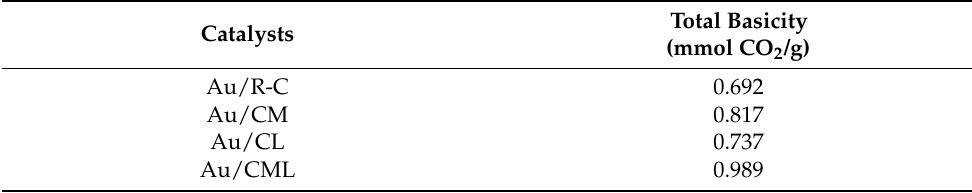
Figure 6. H 2 - TPR profiles of catalysts .